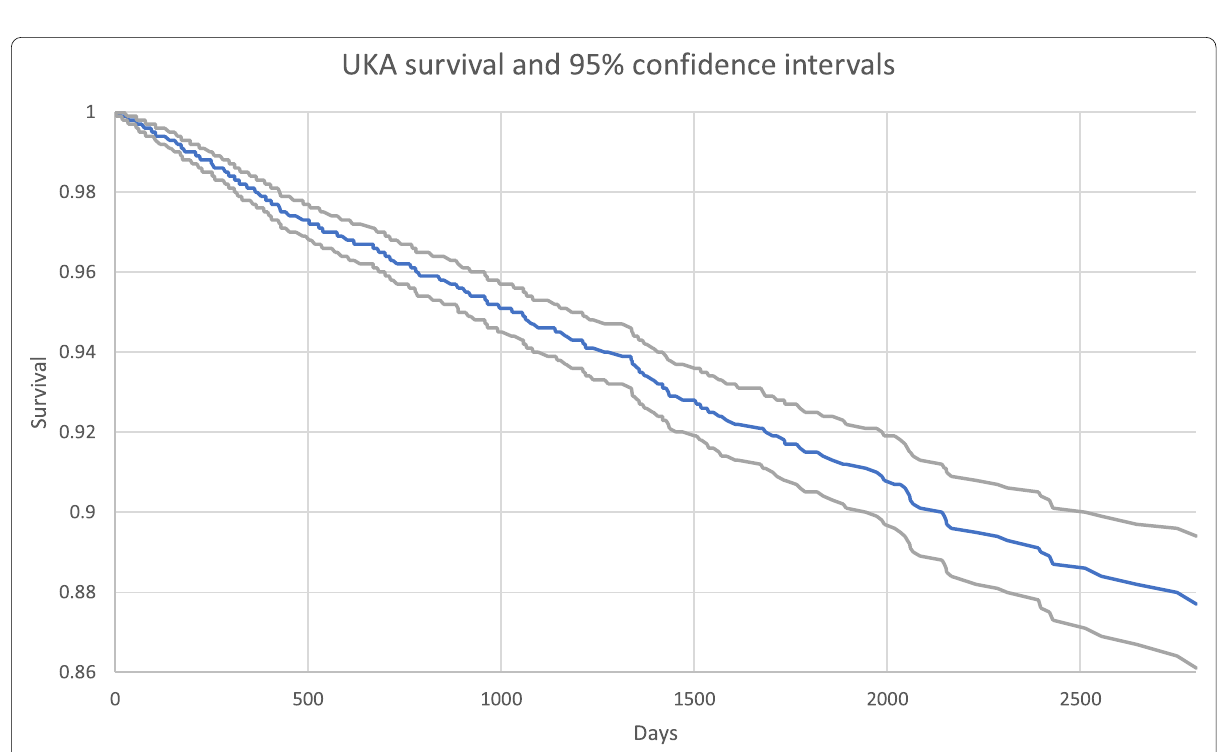
Fig. 2 UKA survival and 95% confidence